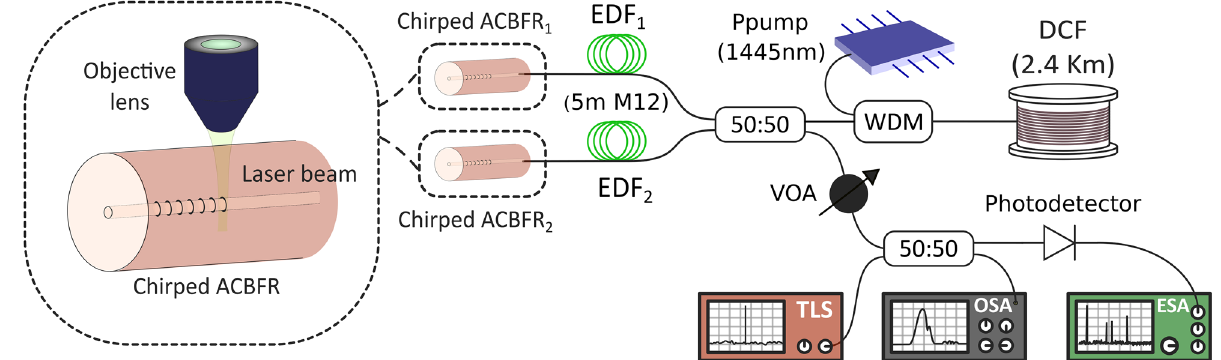
Figure 2. Experimental setup of the experimental half-open cavity RFL based on two chirped artificially controlled backscattering fiber reflectors